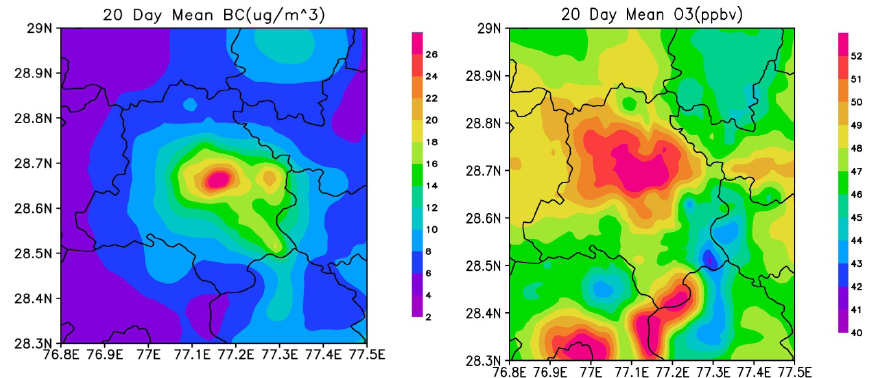
Figure 5. Spatial distributions of calculated 20-day mean concentrations of surface BC (µgm − 3 ) and daytime (9.30am–6.30pm IST) ozone (ppb) over Delhi. For ozone daytime means are shown.